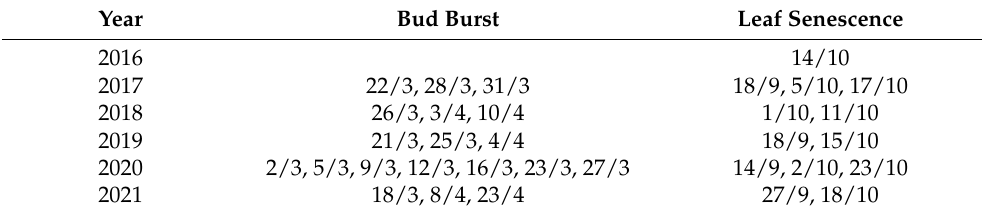
Table 1. Observation dates of the phenophases bud burst and leaf senescence. Year Bud Burst Leaf